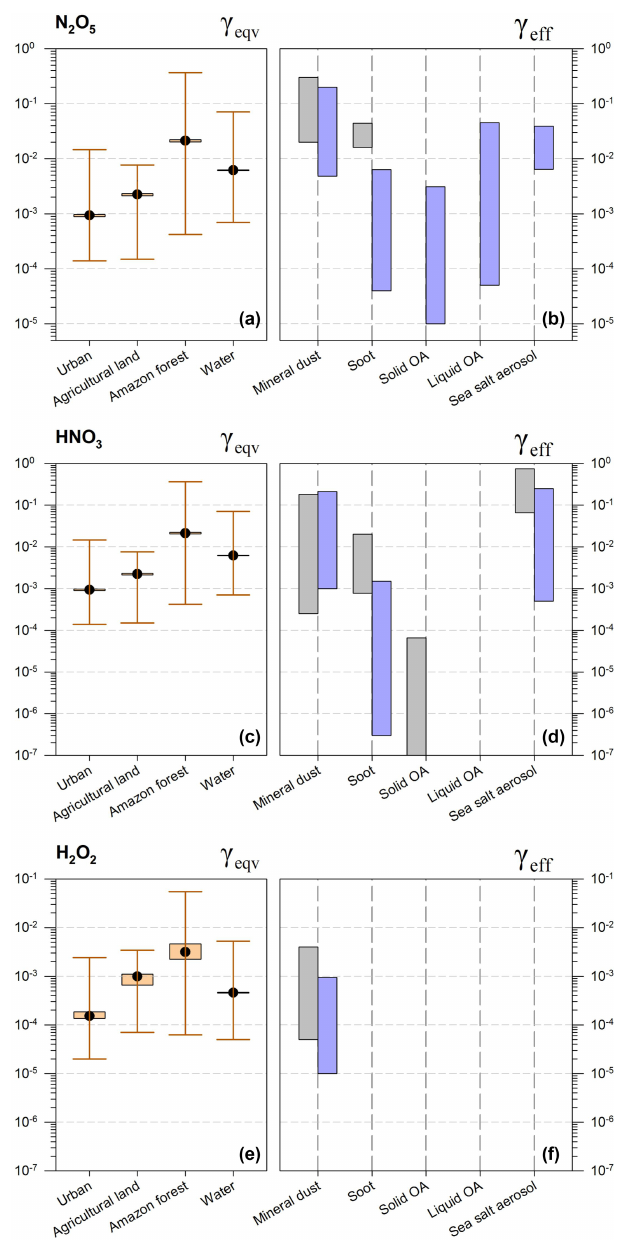
Figure 5. Uptake coefficients ( γ eqv , a, c, e ; γ eff , b, d, f ) for N 2 O 5 , HNO 3 and H 2 O 2 on different ground types and